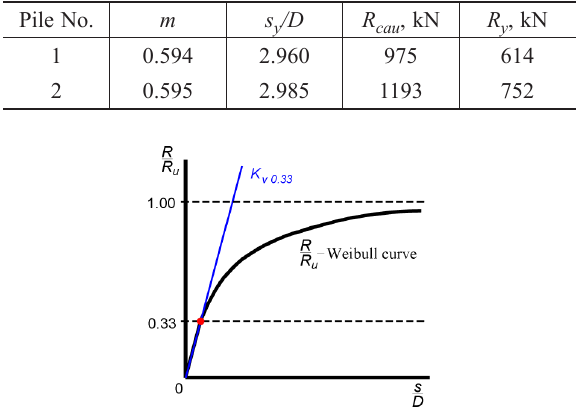
Table 4. Parameters of curves